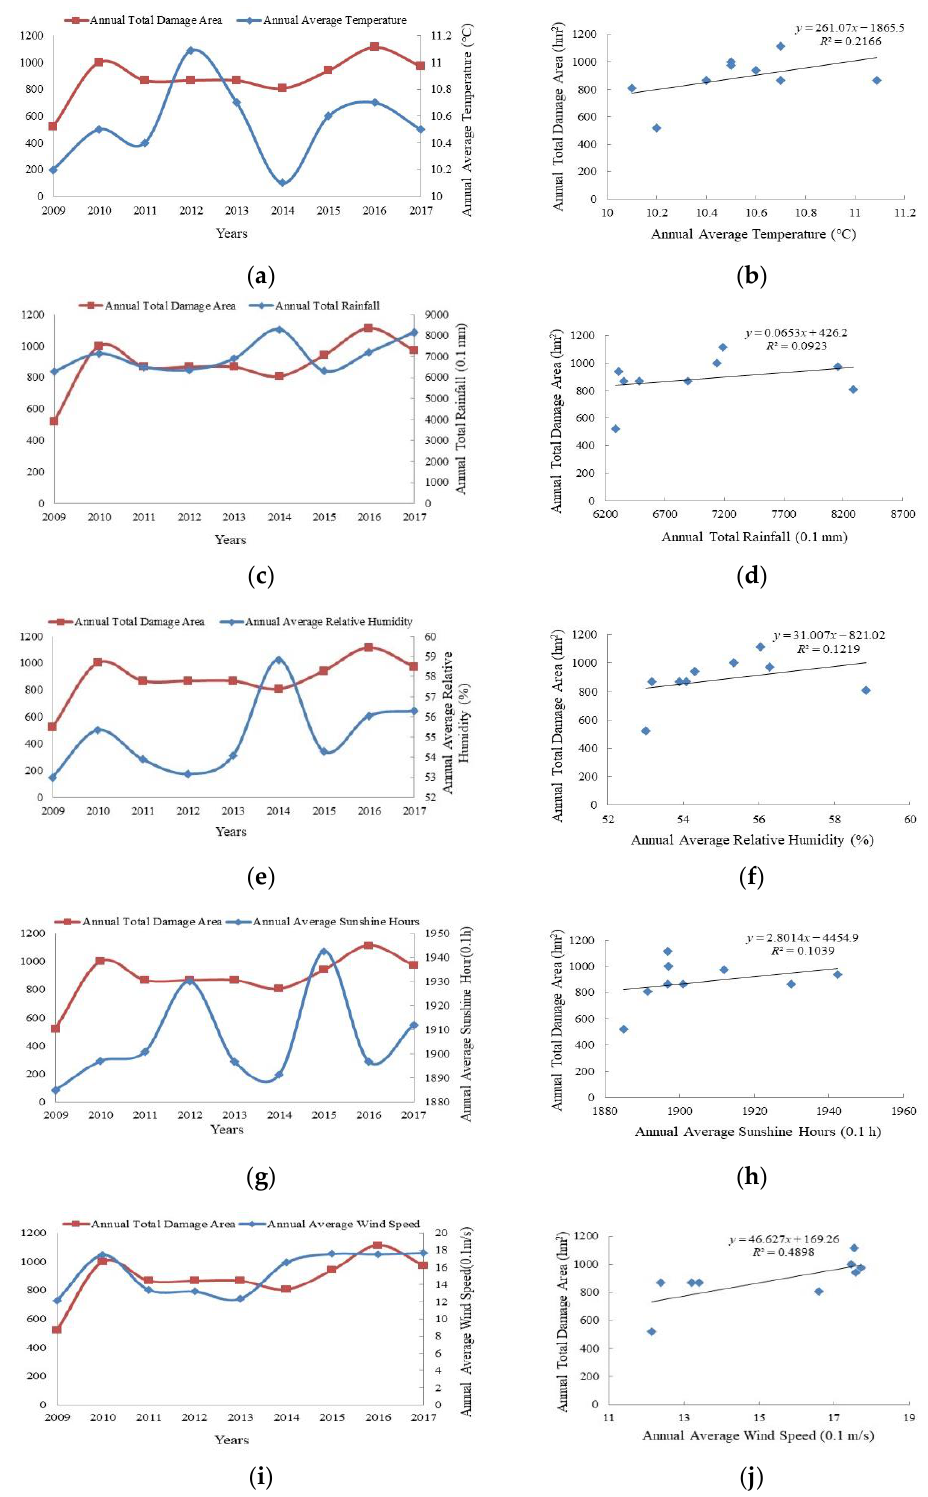
Figure 7. The relationship between annual climate factors and the annual total damage area by Lophodermium piceae : ( a ) the relationship between annual total damage area and annual average temperature; ( b ) the trend obtained by fitting annual total damage area to annual average temperature; ( c ) the relationship between annual total damage area and annual total rainfall; ( d ) the trend obtained by fitting annual total damage area to annual total rainfall; ( e ) the relationship between annual total damage area and annual average relative humidity; ( f ) the trend obtained by fitting annual total damage area to annual average relative humidity; ( g ) the relationship between annual